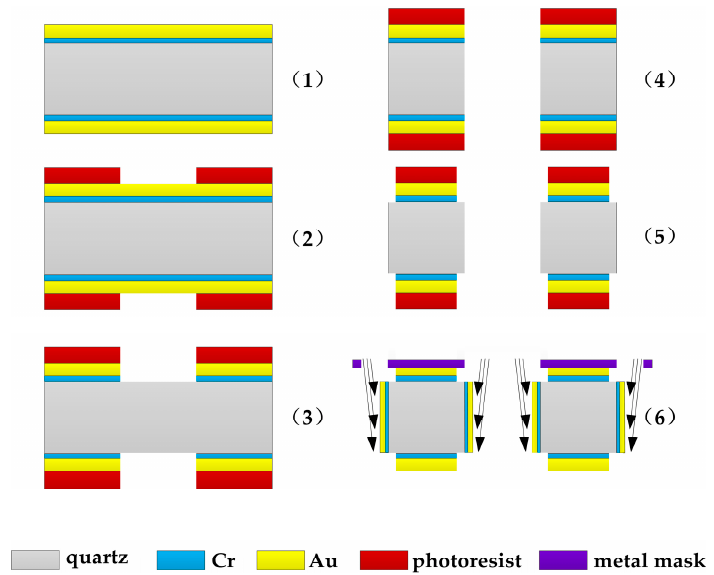
Figure 11. The schematic of the main fabrication process of quartz DETF; (1) Sputtering Cr/Au layer; (2) Photoetching; (3) Etching the Cr/Au layer; (4) Etching the quartz; (5) The fabrication of electrodes on the planar surface; (6) Depositing the sidewall electrodes.